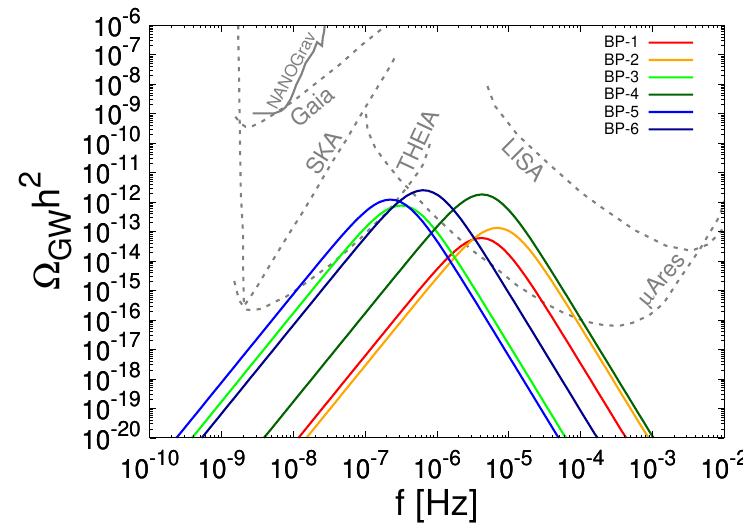
Figure 2 . Gravitational wave spectra for the benchmark points in table